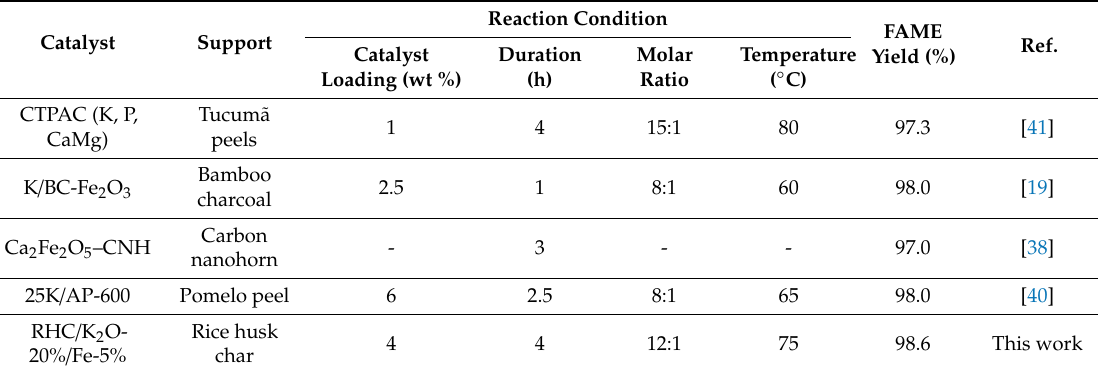
Table 3. Comparison of RHC / K 2 O-20% / Fe-5% catalyst activity with biochar-supported